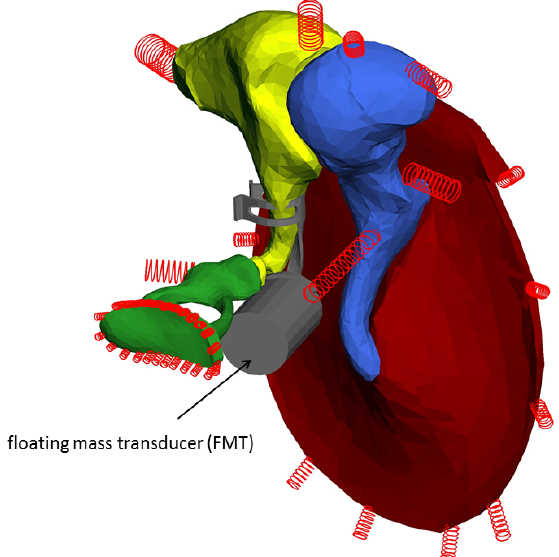
Figure 6. Middle ear with FMT (gray) crimped at the long process of the incus